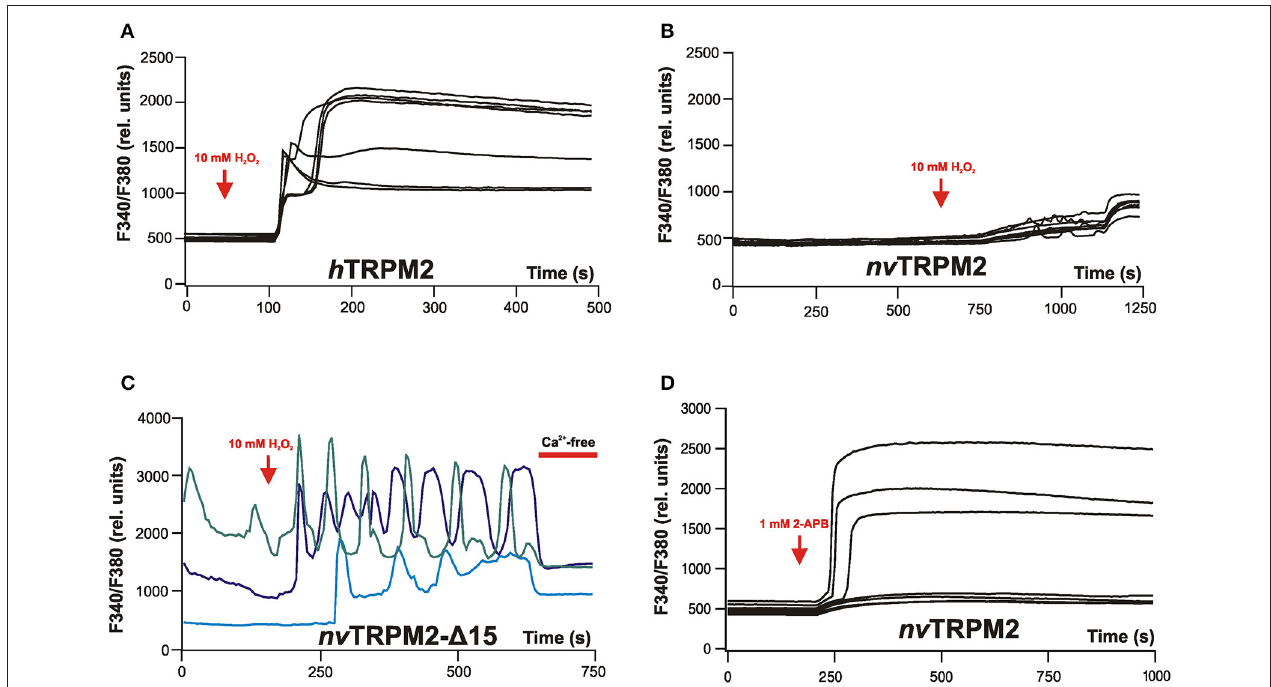
FIGURE 4 | Calcium imaging reveals typical effects on intracellular Ca 2 + concentrations evoked by stimulation of either h TRPM2 or of nv TRPM2 channels in HEK-293 cells. (A) Characteristic changes of the intracellular Ca 2 + concentration of cells transfected with human TRPM2 after extracellular stimulation of the cells with 10mM H 2 O 2 . Note the plateau-like increases in [Ca 2 + ] i . (B) Cells transfected with nv TRPM2 do not respond to oxidative stress. (C) Cells are transfected with a channel variant of nv TRPM2 where the ADPRase activity of the NUDT9H domain has been disrupted by a deletion. H 2 O 2 induces characteristic oscillations of [Ca 2 + ] i . For better distinction, the individual curves are highlighted in different colors. After replacing the standard bath solution (containing 1.2mM Ca 2 + ) with a divalent-free bath solution (containing 10mM EGTA) the oscillations stop. (D) Stimulation of nv TRPM2 by extracellular application of 2-APB (1mM). A plateau-like increase in [Ca 2 + ] i results because 2-APB is an activator and prevents channel inactivation at the same time. Responses of non-transfected cells are shown as negative control. Figures are slightly modified from Kühn et al. (2015,